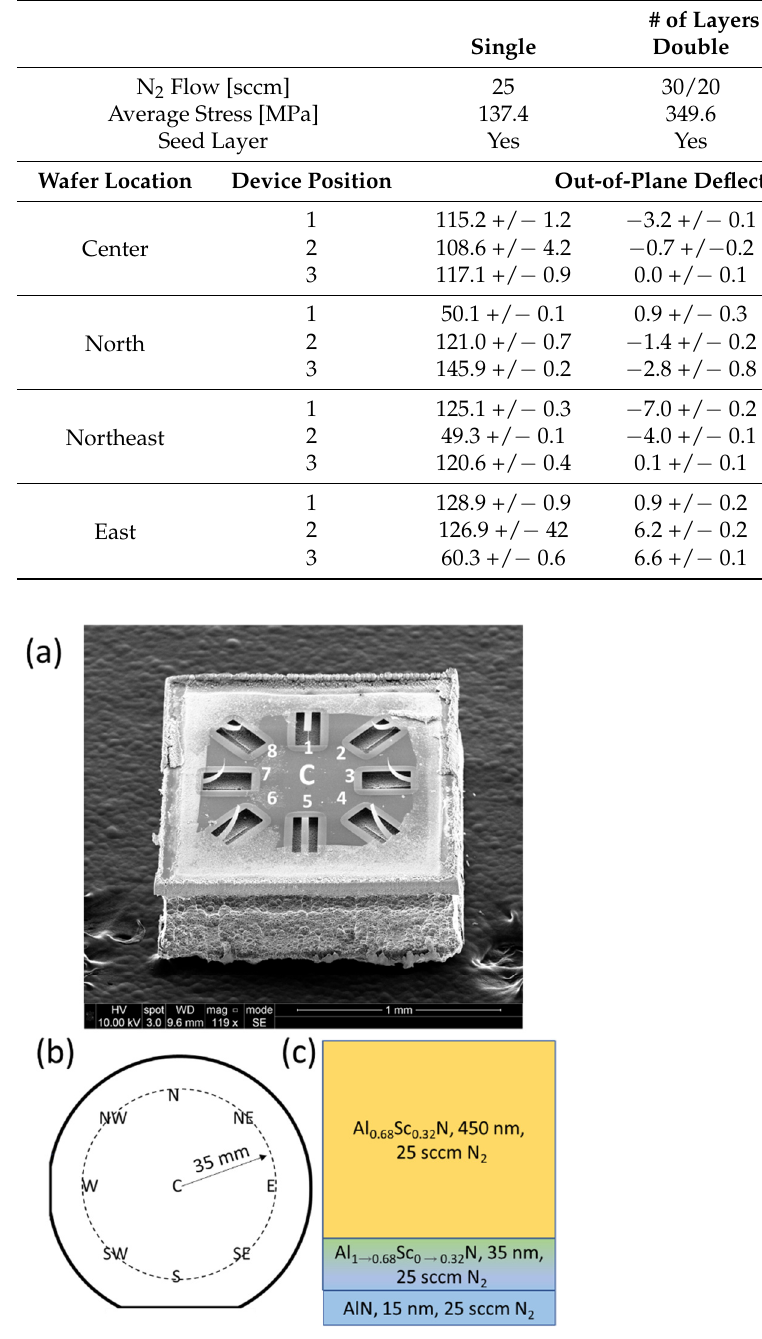
Figure 3. Graphics for a 500 nm PVD sputter-deposited Al 0.68 Sc 0.32 N film where the N 2 process gas flow is held constant through the entire deposition, ( a ) 45-degree SEM image of center die (C) fabricated from a 100 mm wafer. Each die has 8 released structures which are labeled. Note the high out-of-plane deflection that is clearly visible in the uncompensated structures. ( b ) Schematic of locations on the 100 mm wafer where a die is pulled 35 mm from the center for imaging and measuring out-of-plane displacements. One die was pull from the north (N), northeast (NE), east (E), southeast (SE), south (S), southwest (SW), west (W), and northwest (NW) locations of the wafer ( c ) Stack-up of film with constant flow composed of a seed layer, gradient seed layer (Al 1 → 0.68 Sc 0 → 0.32 N) [3] and Al 0.68 Sc 0.32 N layer.